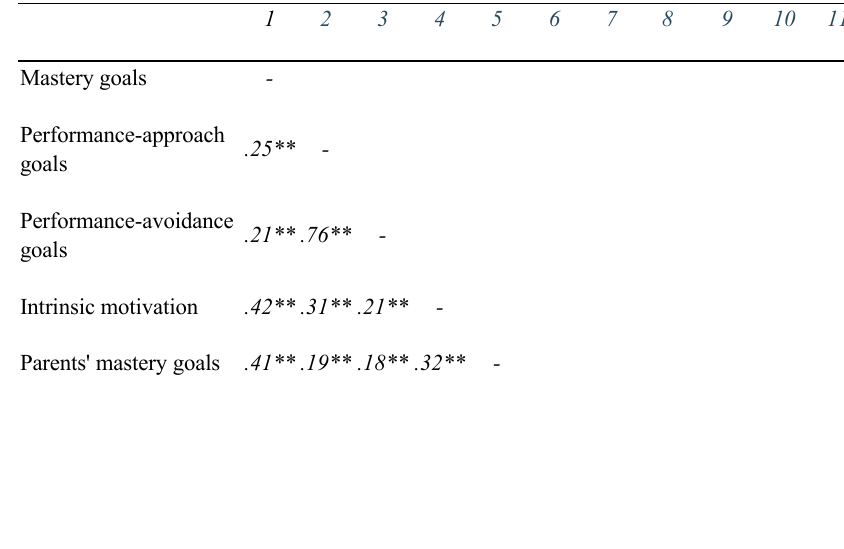
Correlations Between Variables